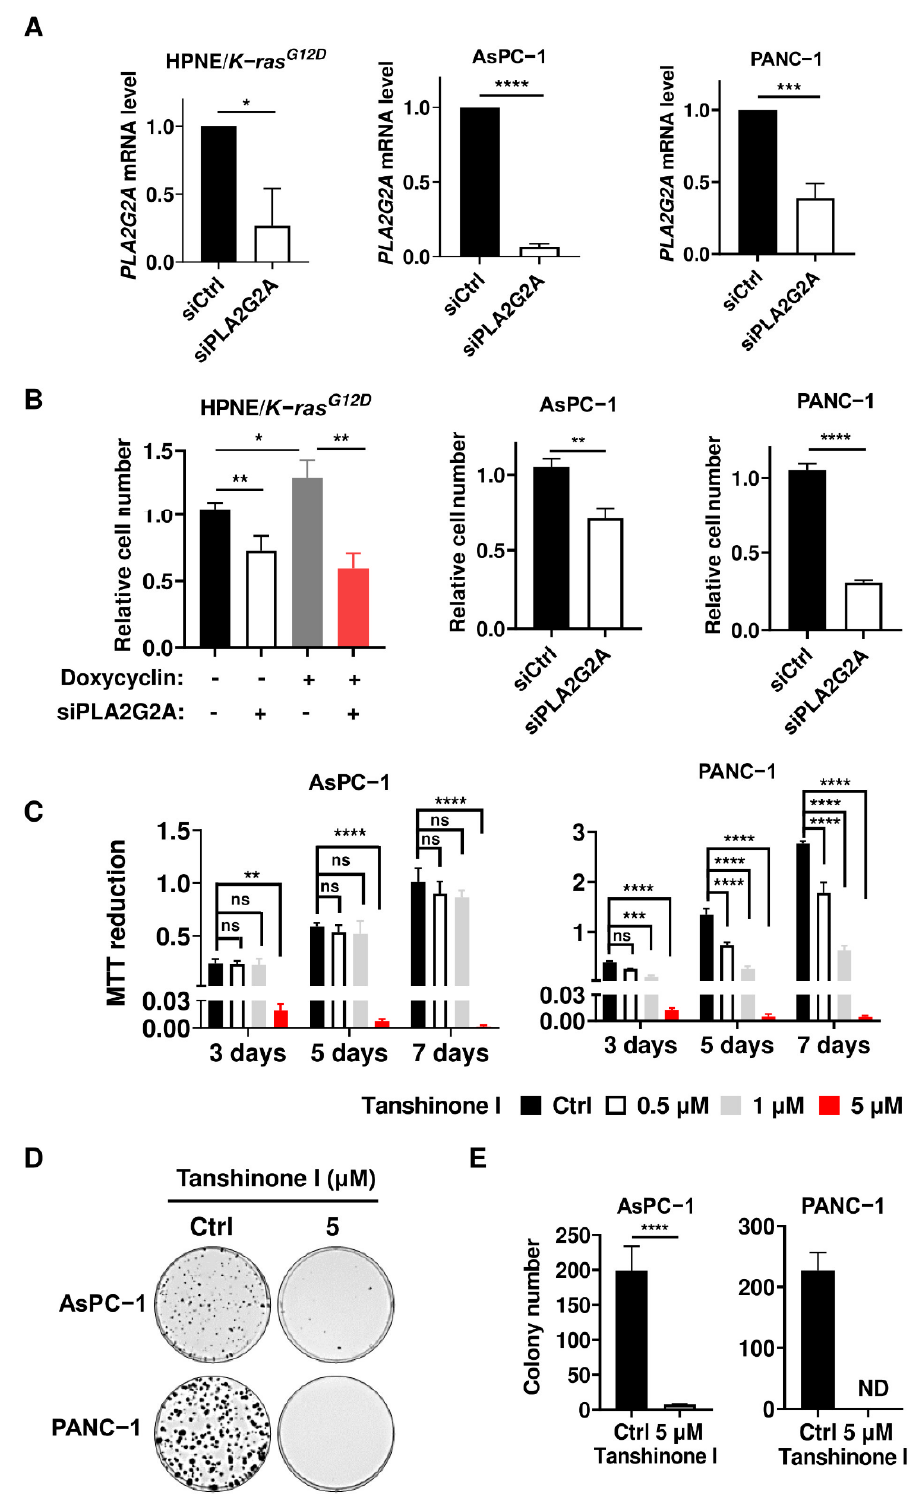
Figure 2. Suppression of PLA2G2A inhibits PDAC cell proliferation. ( A ) PANC-1, AsPC-1, and HPNE/ K-ras G12D cells (stably induced with doxycycline to express oncogenic K-ras for 1 month) were transfected with 50 nM siRNA against PLA2G2A for 72 h, and the PLA2G2A mRNA level was quantified by qRT-PCR. ( B ) PANC-1, AsPC-1, HPNE/ K-ras G12D /OFF, and K-ras G12D /ON cells were transfected with 50 nM siRNA against PLA2G2A for 72 h and then seeded in 6-well plates for 72 h. Cell proliferation was measured by counting the number of cells. ( C ) PANC-1 and AsPC-1 cells were